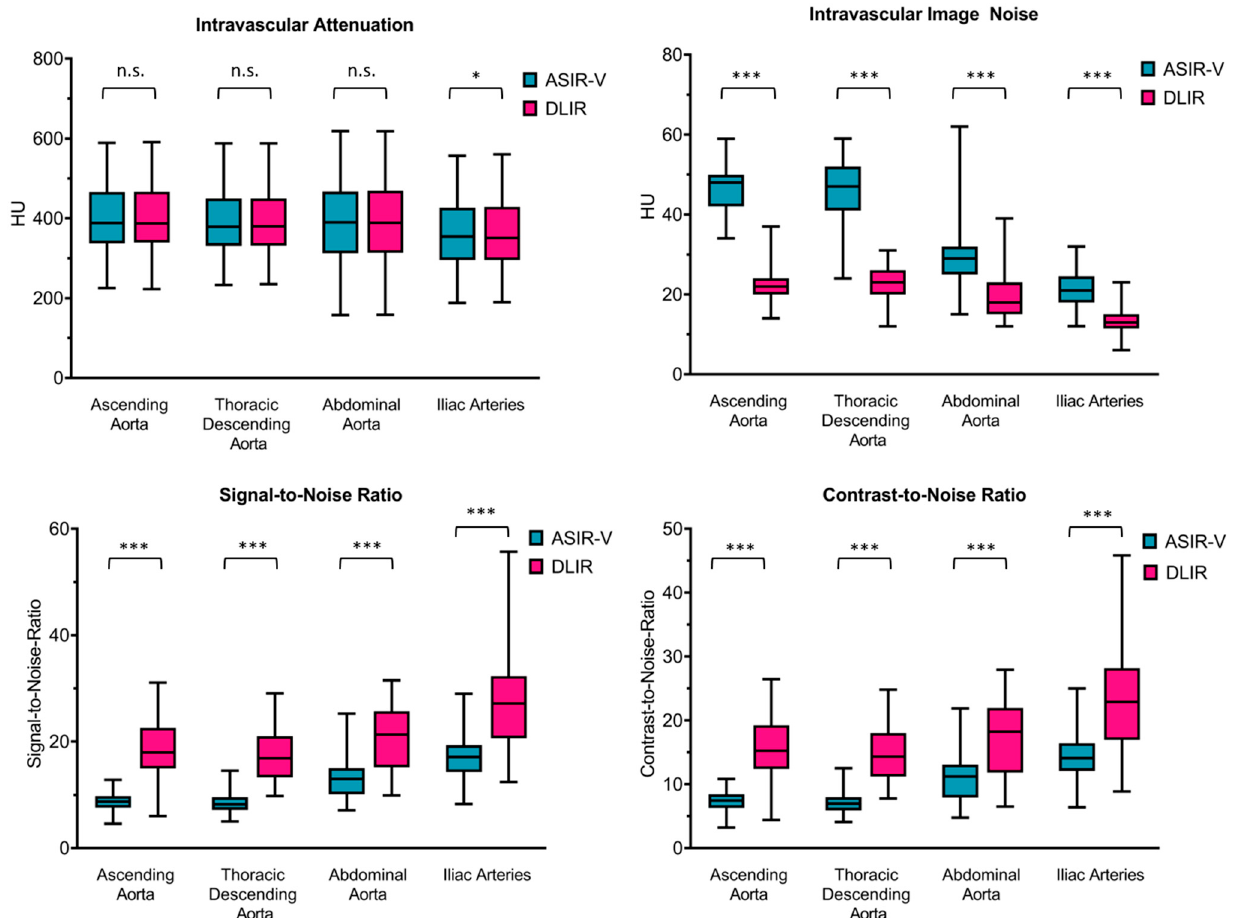
Figure 3. Objective image quality. Figure 3 data are shown as boxplots with the whiskers ranging from the lowest to the highest value, with the box extending from the 25th to the 75th percentile and the median plotted as the line inside the box. Turquoise: ASIR-V = adaptive statistical iterative reconstruction V, magenta red: DLIR = deep learning-based image reconstruction, HU = Hounsfield units. For comparisons between DLIR and ASIR-V, the level of statistical significance is shown as n.s. for not significant, * for p < 0.01 and *** for p < 0.0001.